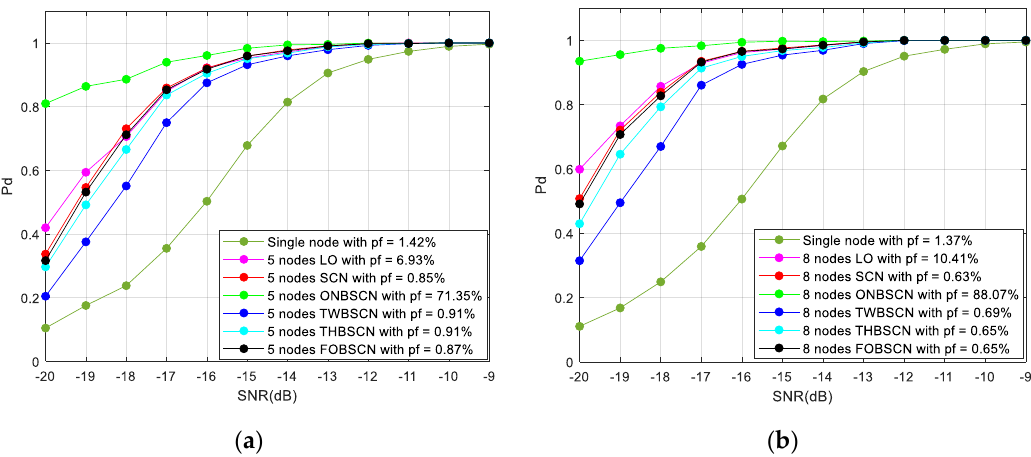
Figure 5. Detection performance of QBCSS over different quantized information bits. ( a ) Five-node QBCSS; ( b ) eight-node QBCSS. Where “ONBSCN” represents one-bit quantization, “TWBSCN” represents two-bit quantization, “THBSCN” represents three-bit quantization and “FOBSCN” represents four-bit quantization.